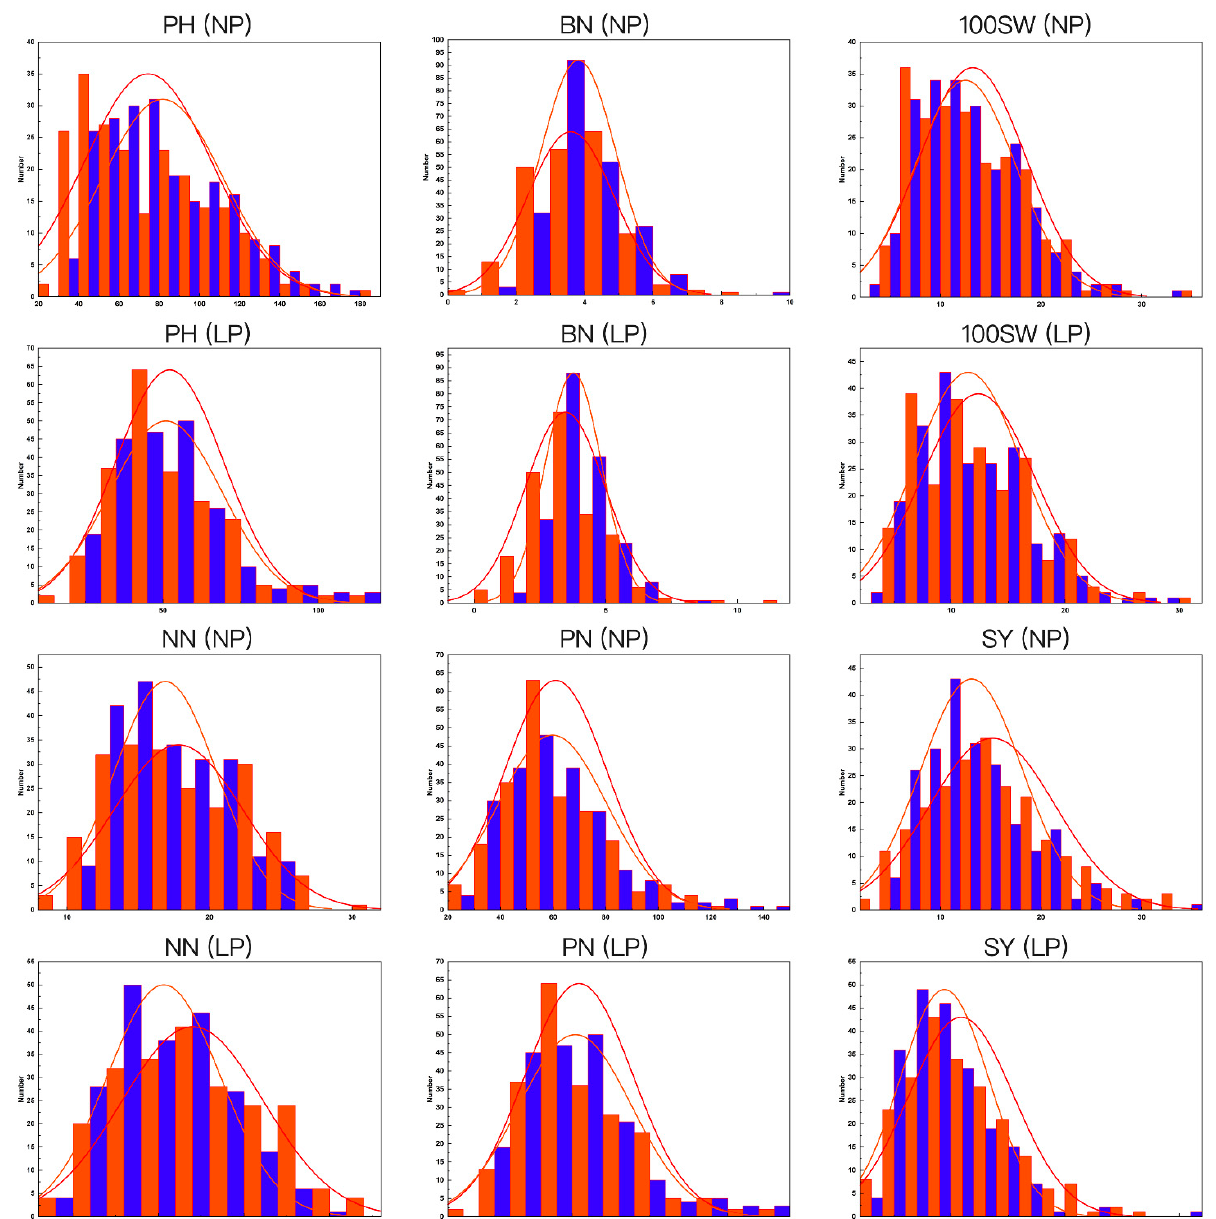
Figure 1. Frequency distribution of phenotypic values of the six soybean P-efficiency-related traits at maturity under NP and LP conditions in E1 and E2. PH (cm): Plant height; NN: Node number of the main shoot; BN: Branch number of the main shoot; PN: Pod number per plant; 100SW (g): 100-seed weight; SY (g): Seed yield per plant; NP (normal phosphorus): Soil available P = 20 mg/kg; LP (low phosphorus): Soil available P < 10 mg/kg; the colours red and purple represent values in E1 and E2, respectively.